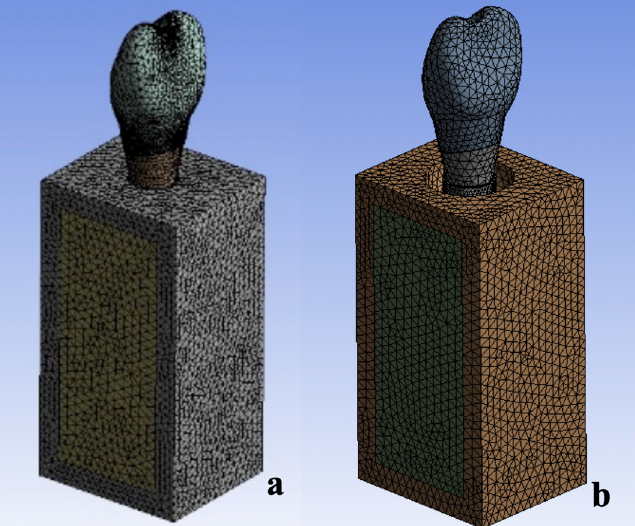
Figure 3. The finite element models (the mesh is shown) of the implant and surrounding bone. ( a ) Models 1 and 3. ( b ) Models 2 and 4. ( a ) Models 1 and 3. ( b ) Models 2 and 4.